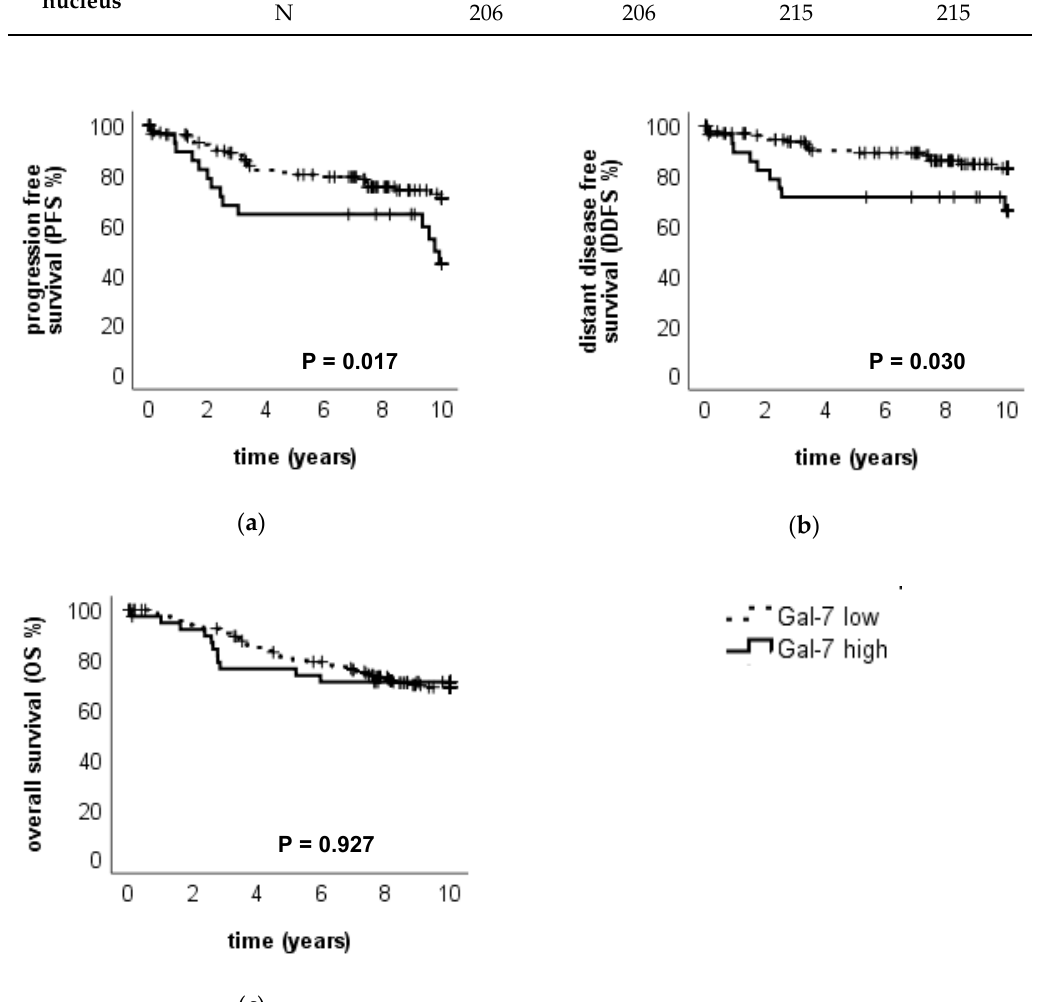
Figure 5. Association of Gal-7 expression in the cytoplasm to the clinical outcome. Kaplan–Meier analysis of PFS ( a ), DDFS ( b ) and OS ( c ) in Gal-7 high- and low-expressing tumors (in the cytoplasm) is shown. Tumors with high Gal-7 expression in the cytoplasm showed a significantly impaired PFS and